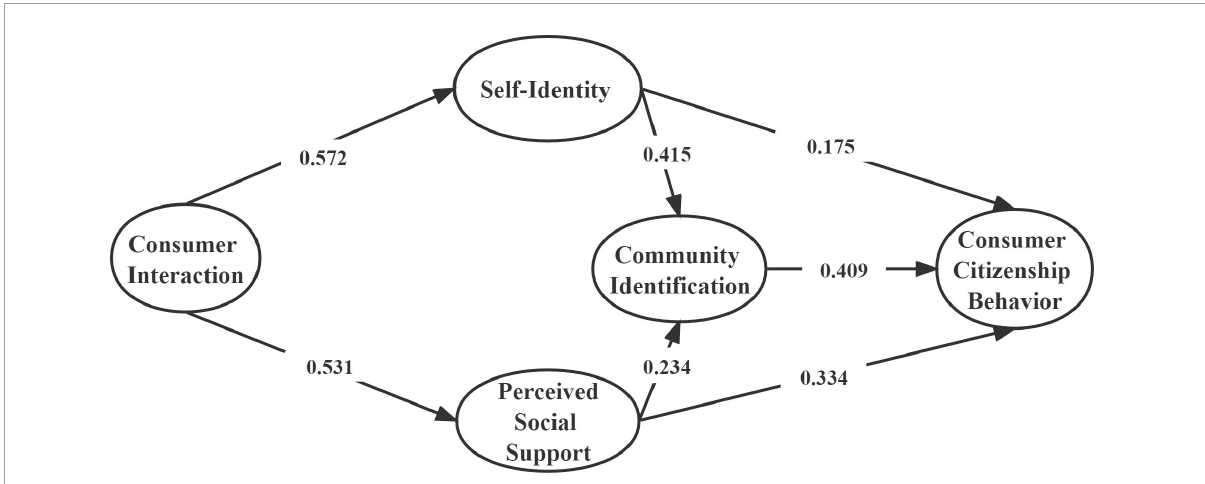
FIGURE4 Standardization path map of limited model of utilitarian/symbolic motivation. χ 2 = 3774.532, df = 1703, χ 2 / df = 2.216, TCL = 0.941, CFI = 0.941, NFI = 0.897, RMSEA = 0.032. When standardized path coefficients were set as equal, the path maps were the same for both utilitarian and symbolic motivation.